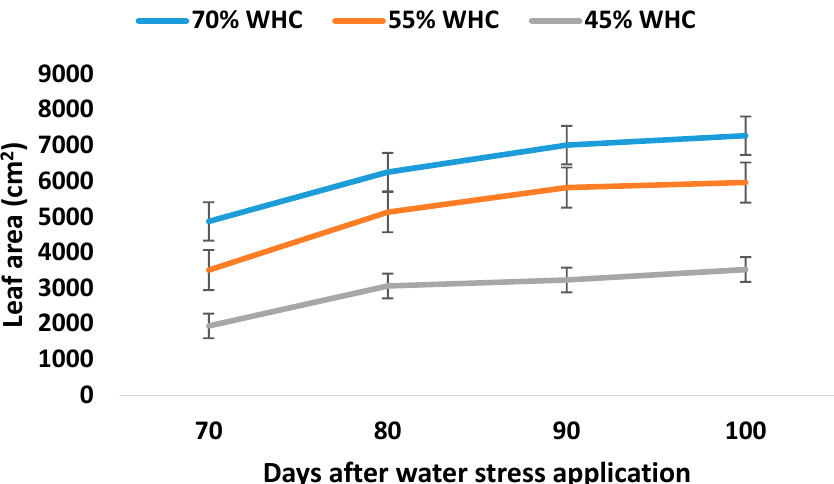
Figure 3. Castor leaf area as affected by the water deficit. Table 2. Leaf water potential of castor plants (in MPa, mean values, n = 5). Stress Levels